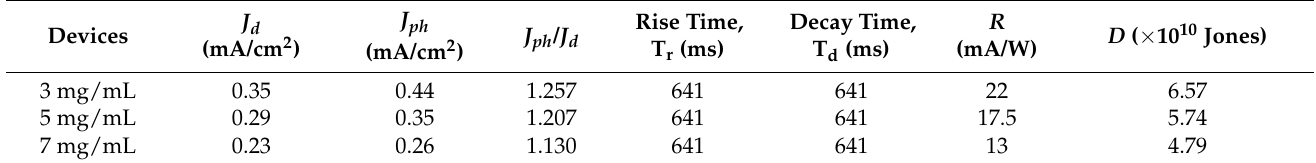
Table 3. Photo-sensing characteristics of P3HT:DDCI-4:OXCBA blended devices of different ratios at − 1